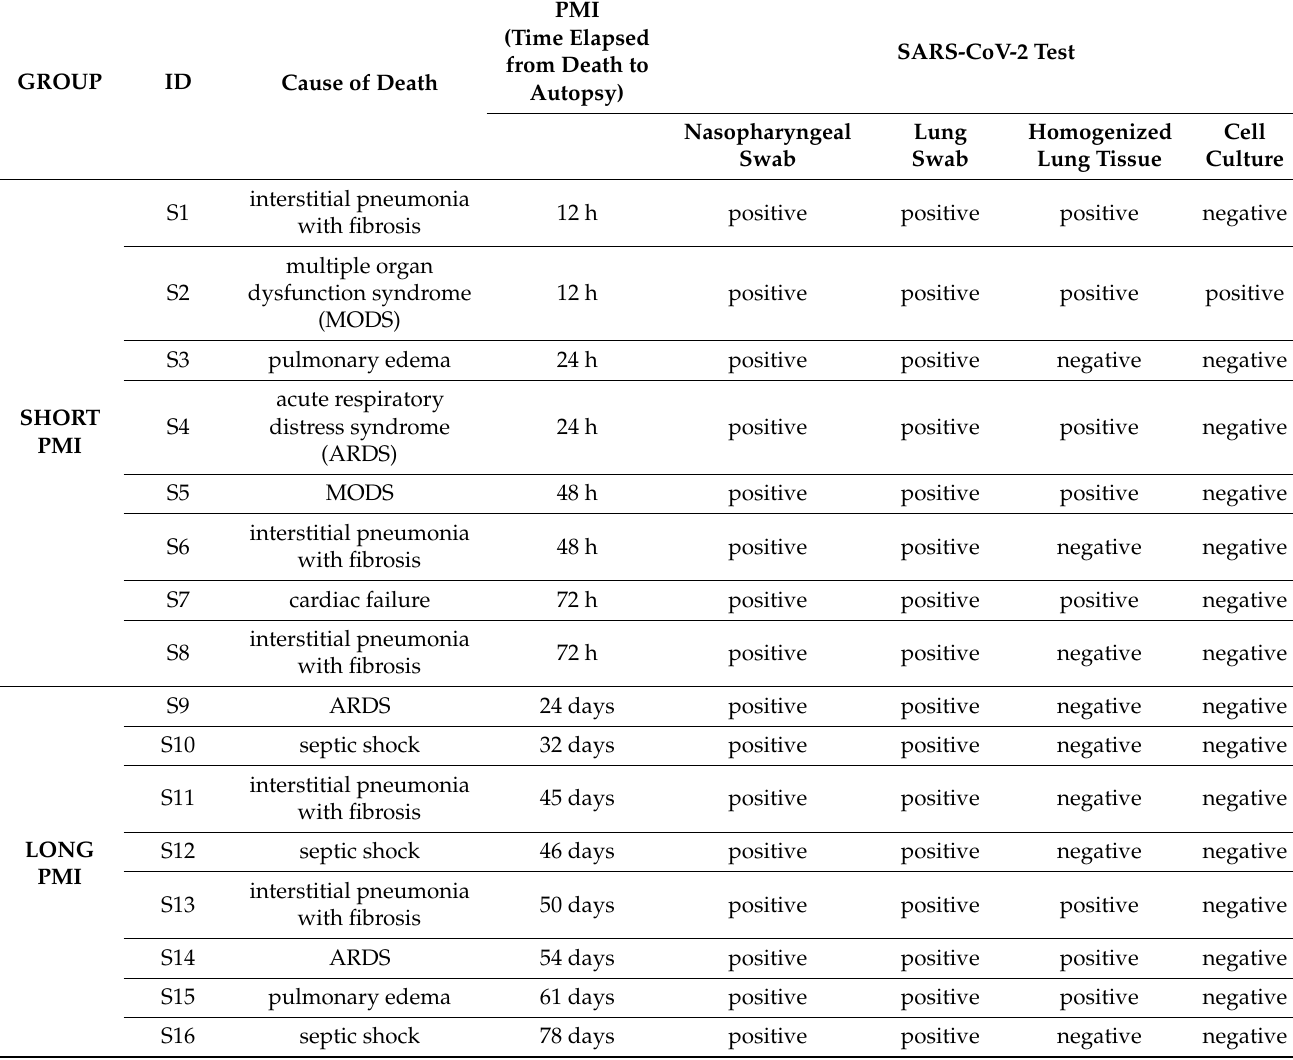
Table 1. Samples enrolled for the study with the indication of the relative PMI. All nasopharyngeal and lung swabs tested positive, while only one cell culture (S2) resulted positivity demonstrating virus